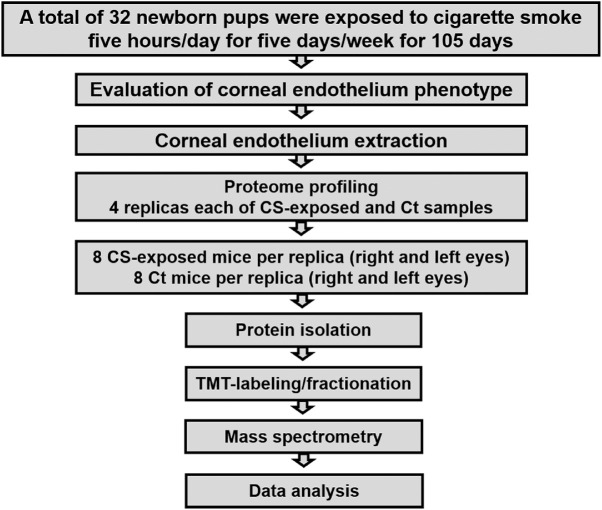
Workflow depicting the protocol used for the characterization of corneal endothelium (CE) from cigarette smoke-exposed (CS-exposed) and control (Ct) mice through a proteome profiling approach. Briefly, 32 newborn mice were exposed to CS in a smoking chamber for 5 h/d, 5 d/wk, for a total of 105 days (3.5 months). Subsequent to exposure, the CS-exposed and age-matched Ct mice were examined for CE-associated abnormalities using the ConfoScan4. The CS-exposed and Ct mice were euthanized, and the CE was peeled and used for mass spectrometry-based proteome profiling. The CS-exposed and Ct groups consisted of two male and two female biological replicates.